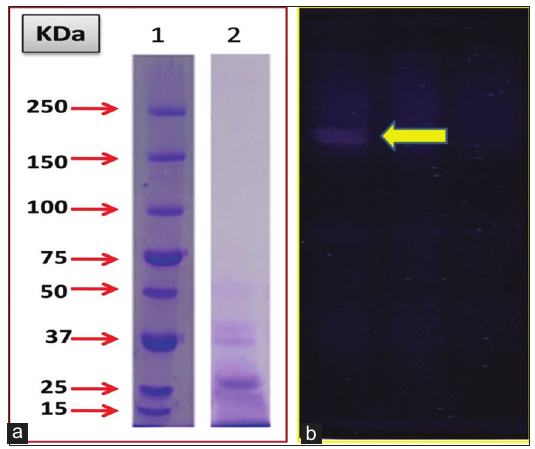
Figure-2: (a) Sodium dodecyl sulfate polyacrylamide gel electrophoresis (PAGE) analysis of purified glutathione S-transferase (GST) from Gastrothylax crumenifer (Gc) in a 12% gel. Lane 1 - standard protein marker (SPM), Lane 2 - purified GST from Gc (GcGST). (b) In-gel activity of purified GST from Gc in 10% native PAGE gel. The activity band appears as an achromatic zone on a blue insoluble formazan